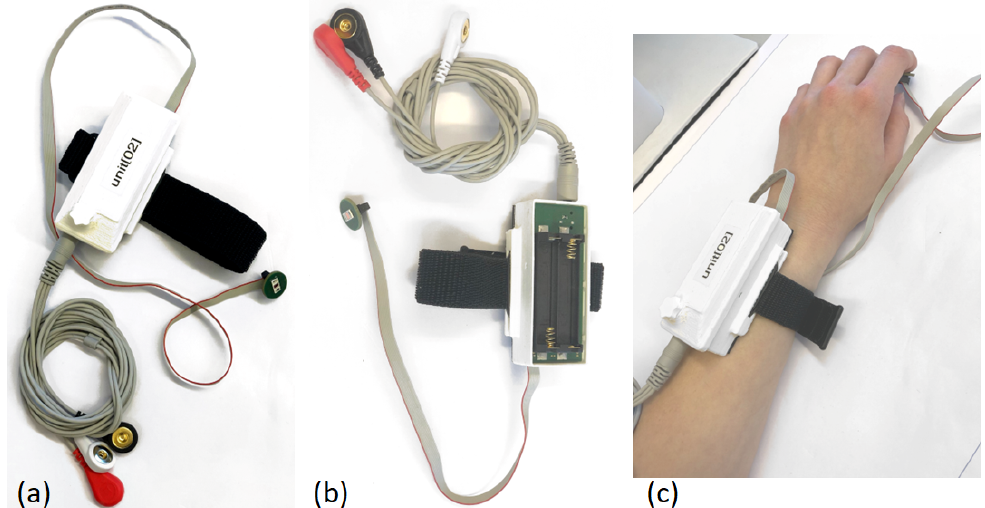
Figure 5. Wearable measuring unit with ECG electrodes, PPG finger sensor and a wrist strap. ( a ) Closed measuring unit with connected ECG electrodes and PPG sensor. ( b ) Measuring unit without the lid showing the battery connector’s accessibility. ( c ) SPECTRE 3.0 assembled on a person’s wrist, showing teh placement of the PPG finger